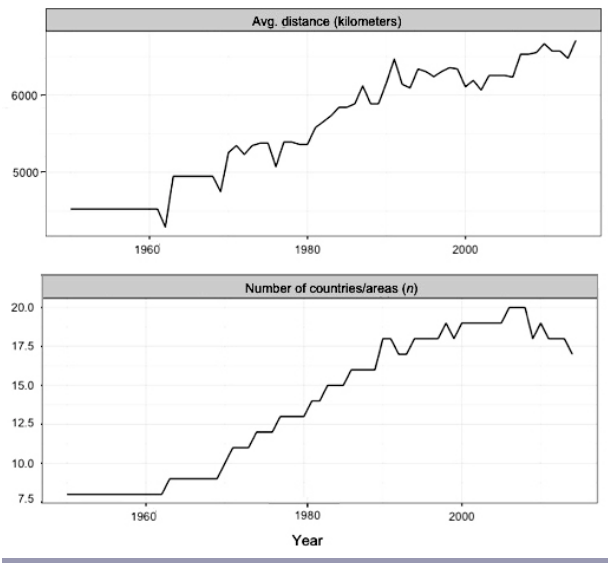
Fig. 4 . Increasing trends in the measures of serial